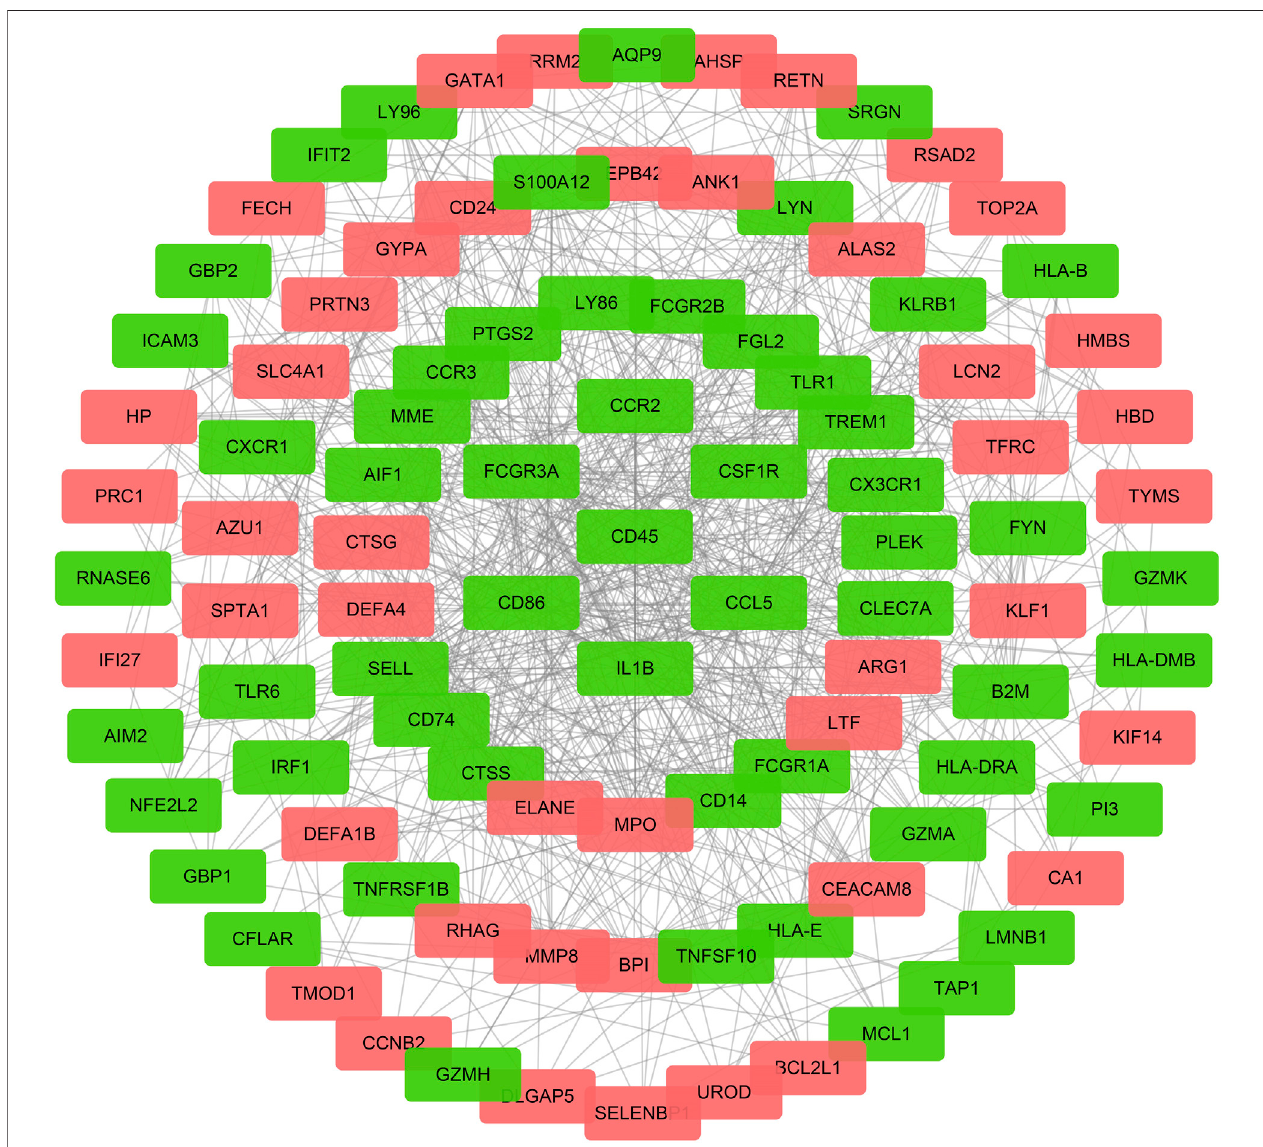
FIGURE 5 | The PPI network for DEmRNAs. The red dots represent the upregulated genes, and the green dots represent the downregulated genes, the gray line represent a correlation between the two genes in DEmRNAs.